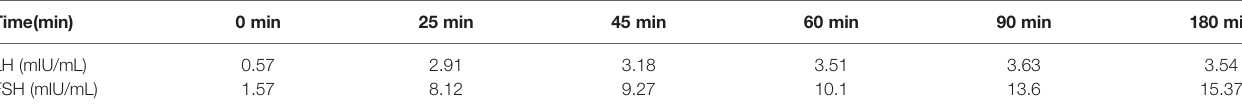
TABLE 2 | The results of GnRH (Triptorelin, 100mg) stimulation test.